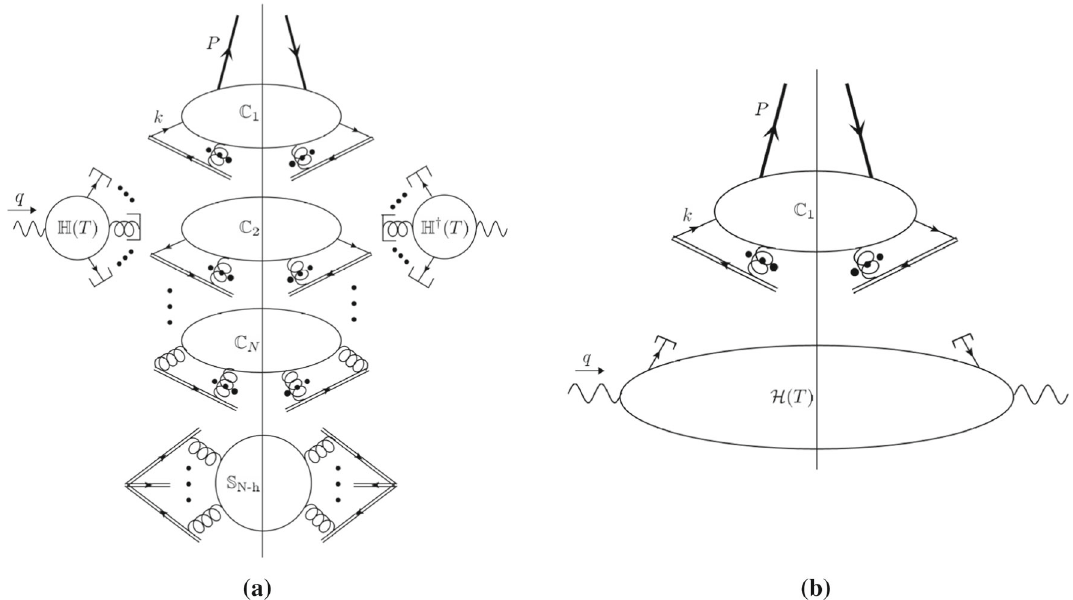
μν as collinear factors corresponding to real emissions have been included H into the hard part. The soft factor of the process is equal to one, as μν expected for a 1-hadron class process (see Sect. . All the H